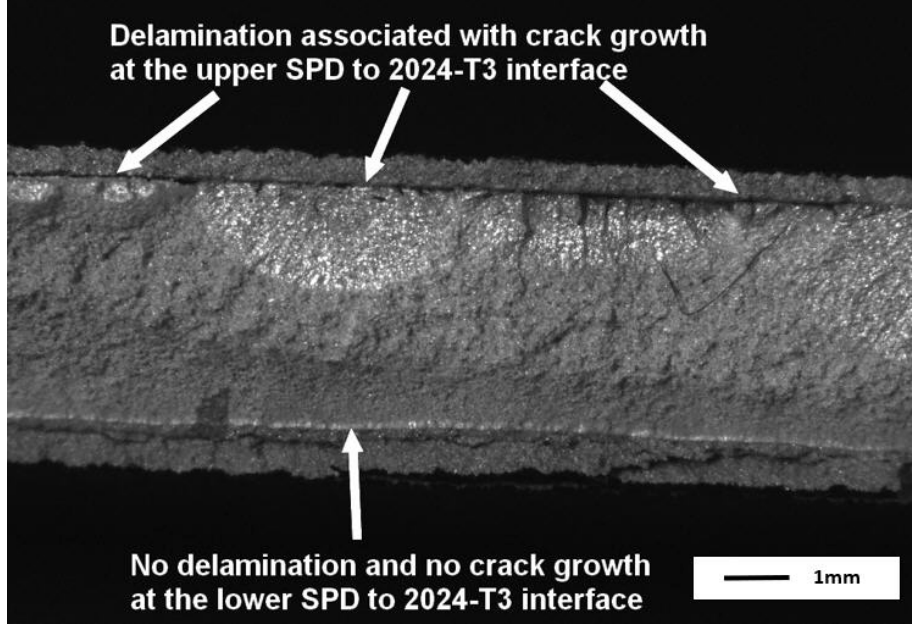
Figure 7. Note the delamination is associated with crack growth on the upper interface and the intact nature of the interface on the opposing (uncracked) surface.